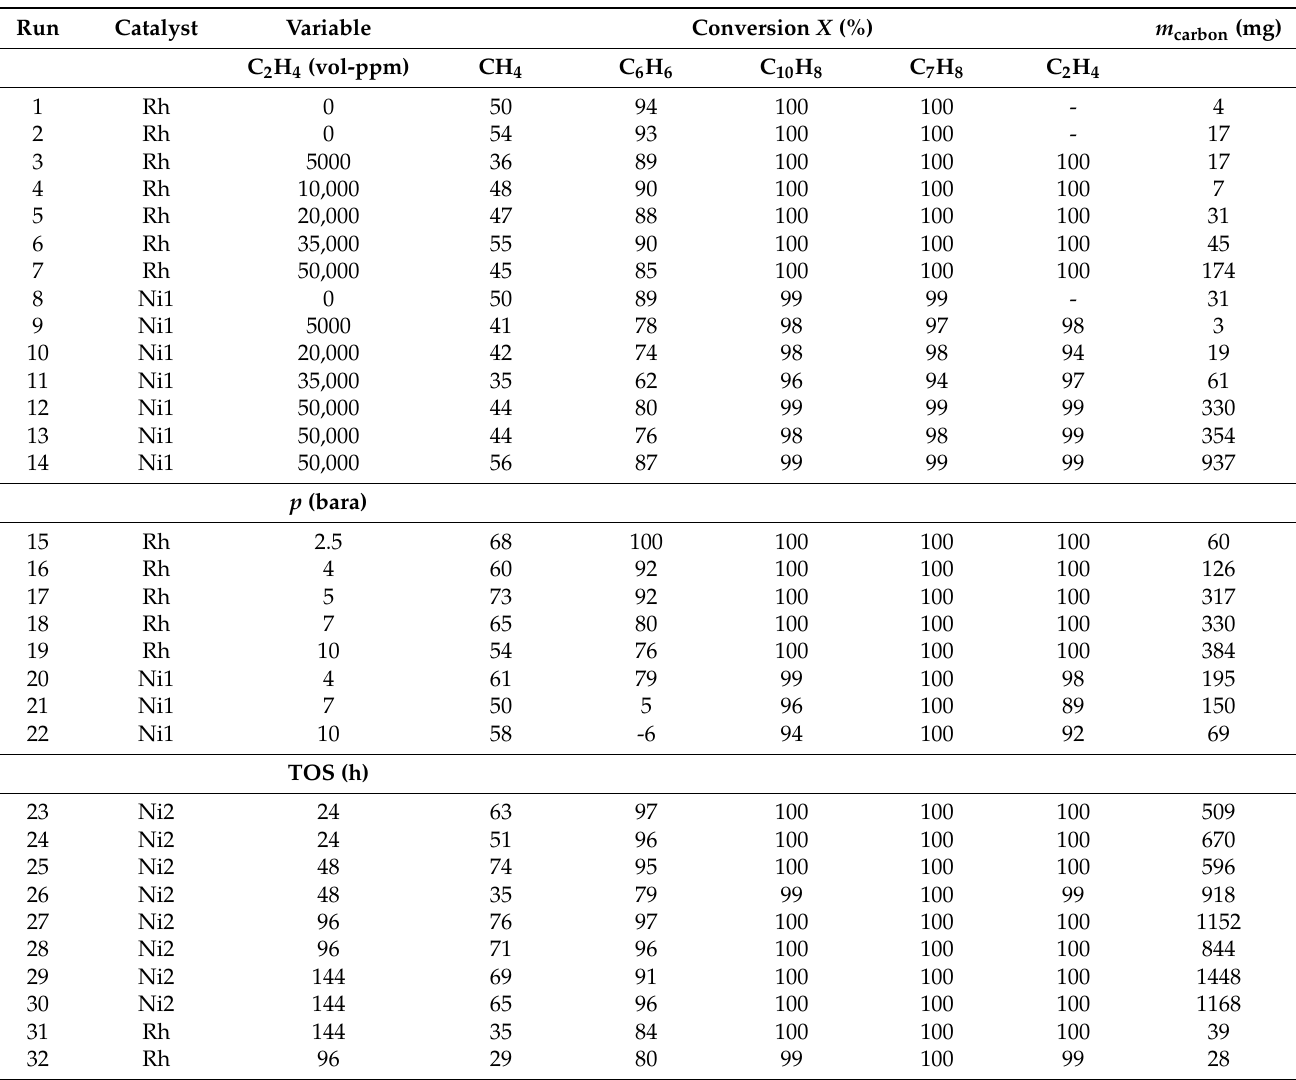
Table 1. Hydrocarbon conversions and obtained carbon from test runs. Ni1 refers to commercial nickel catalyst, Ni2 to in-house nickel